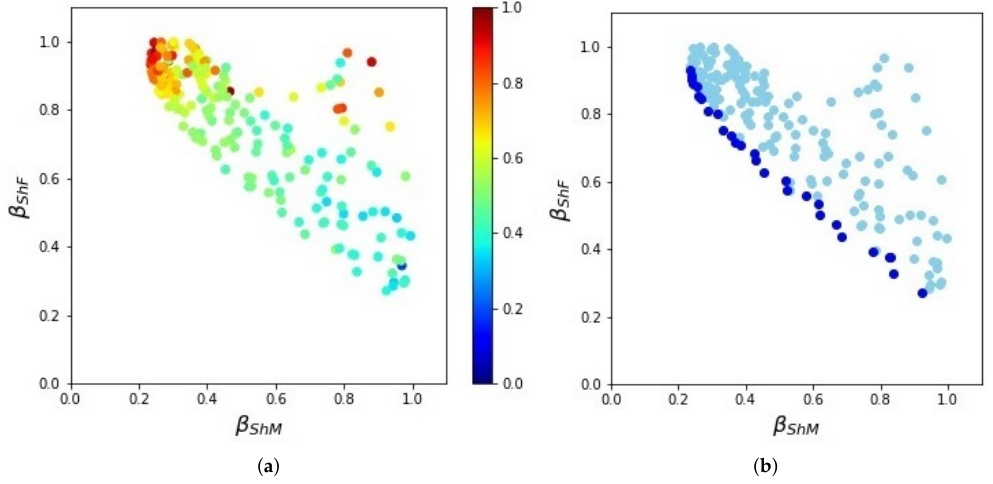
Figure 4. Pareto analysis of the optimization objectives: β ShM and β ShF . ( a ) Optimized β ShM and β ShF according to γ . ( b ) Pareto Front of the optimized